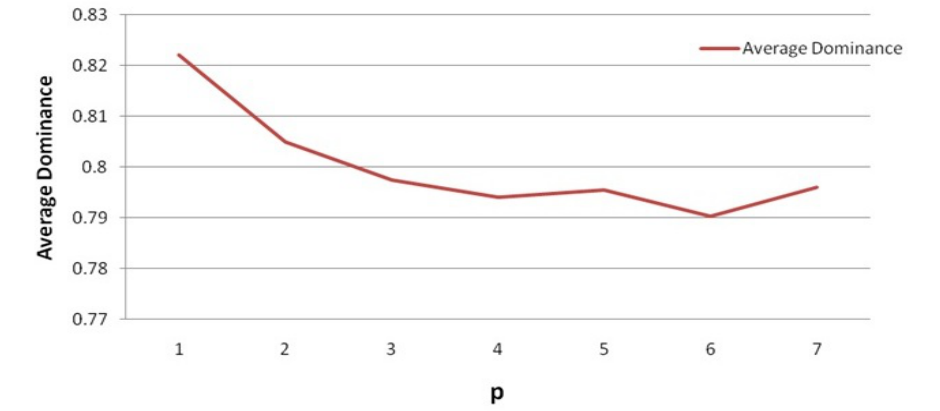
Figure 2: Dominance behavior for different values of p; when n=10 & j=5